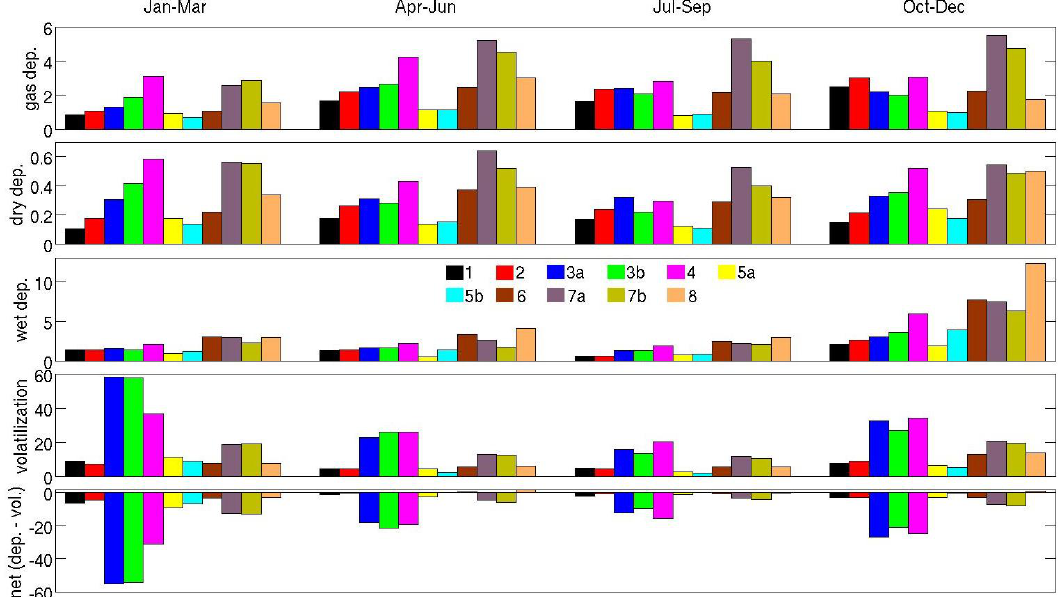
Figure 12. Bar charts of integrated quarterly (3 month) fluxes (kg) by ICES boxes (Figure 1) of PCB 153 in 2000: gas deposition ( top row ), dry deposition ( 2nd row ), wet deposition ( 3rd row ), volatilization ( 4th row ), and net air-sea exchange ( bottom row